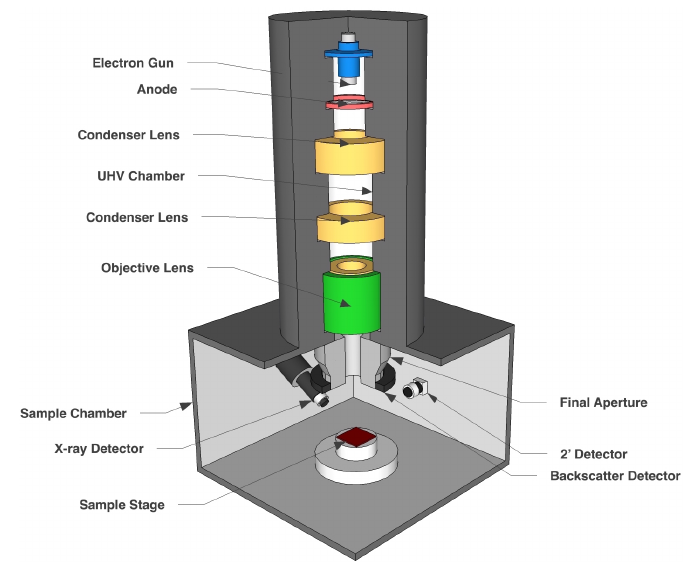
Figure 12. SEM systems are operated under ultra-high vacuum to minimize electron diffraction and to allow the condenser “lenses” to collimate the electron beam. The sample chamber is equipped with as many different detectors as is necessary, but SEM imaging is performed using the secondary 2’ electron